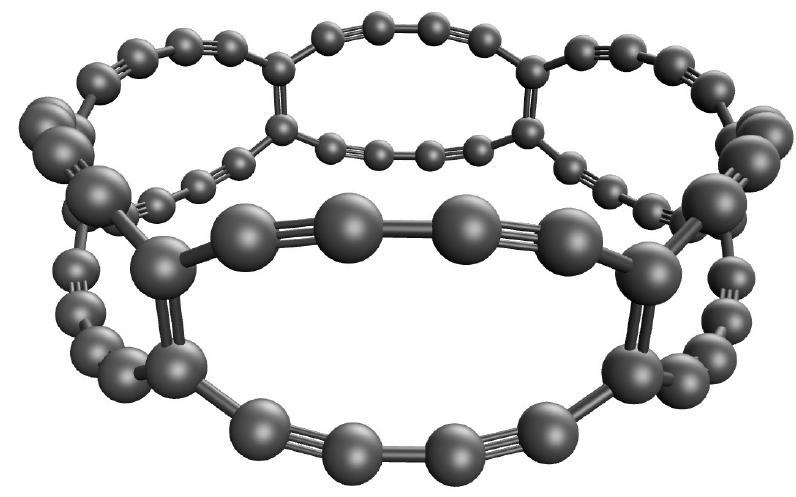
Figure 1. Geometry of C-Belt[6], containing 6 fused 12-membered carbon rings forming a closed